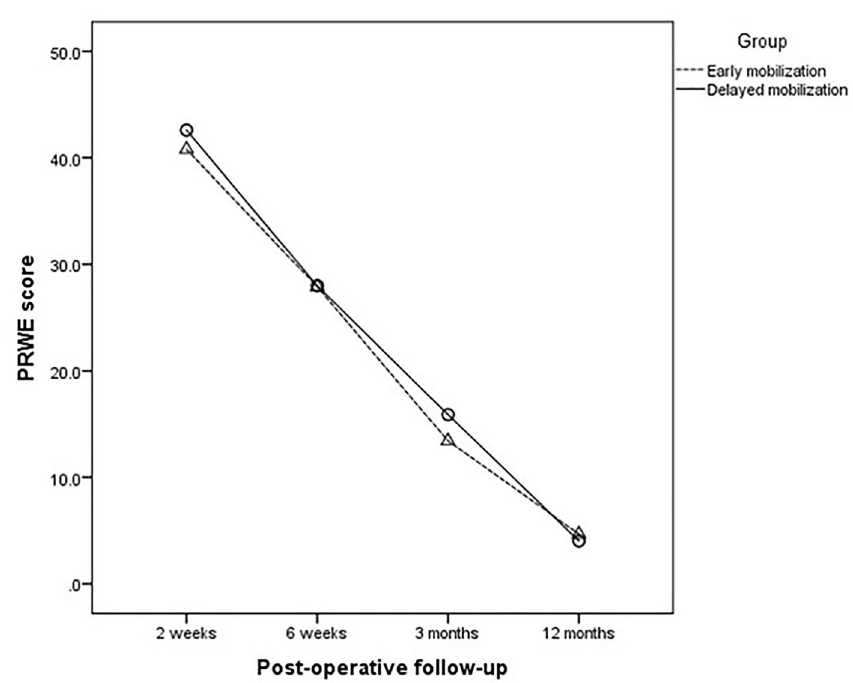
Figure 2. Changes of postoperative patient-rated wrist evaluation (PRWE) scores between the early and delayed mobilization